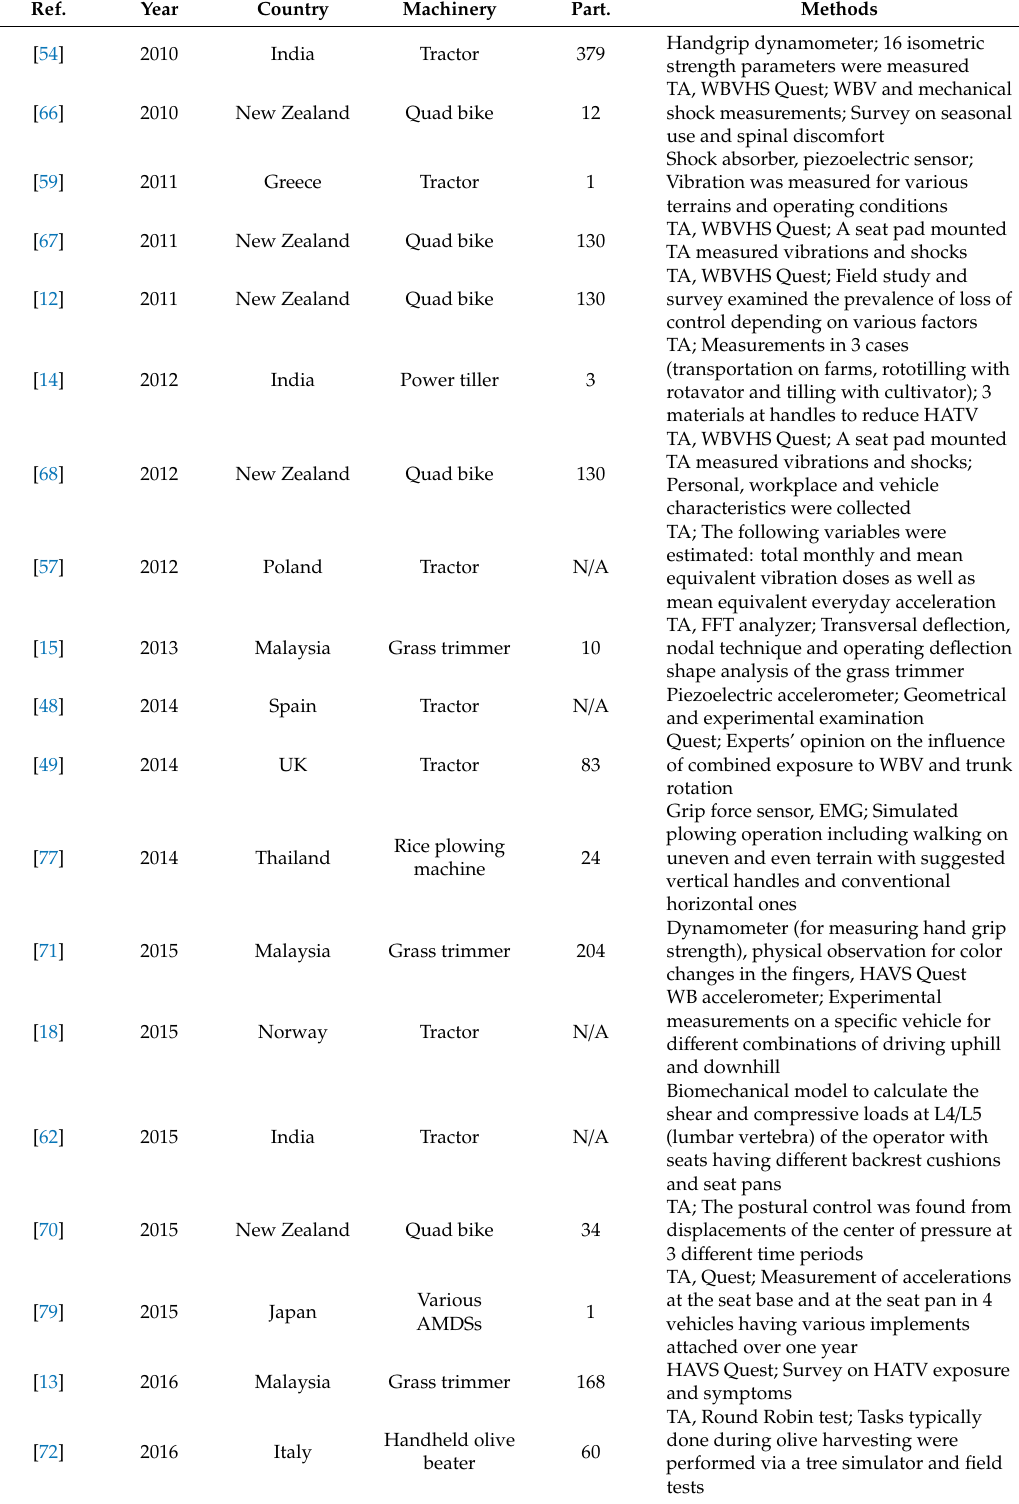
Table 2. List of the selected journal papers along with the date of publishing, country that the survey was conducted, studied machinery, number of participants and methodology.